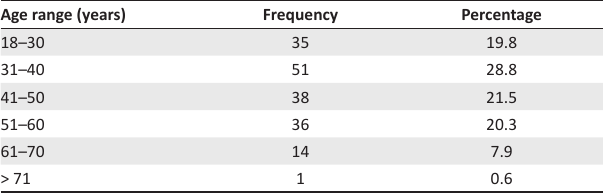
TABLE 1 : Age distribution of participants studied in groups